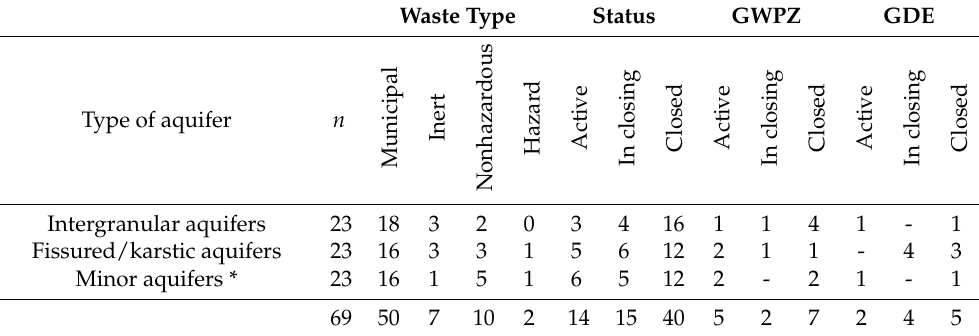
Table 1. Overview of number of landfills by type, status, and location of groundwater protection zones and groundwater dependent-ecosystems according to status of the